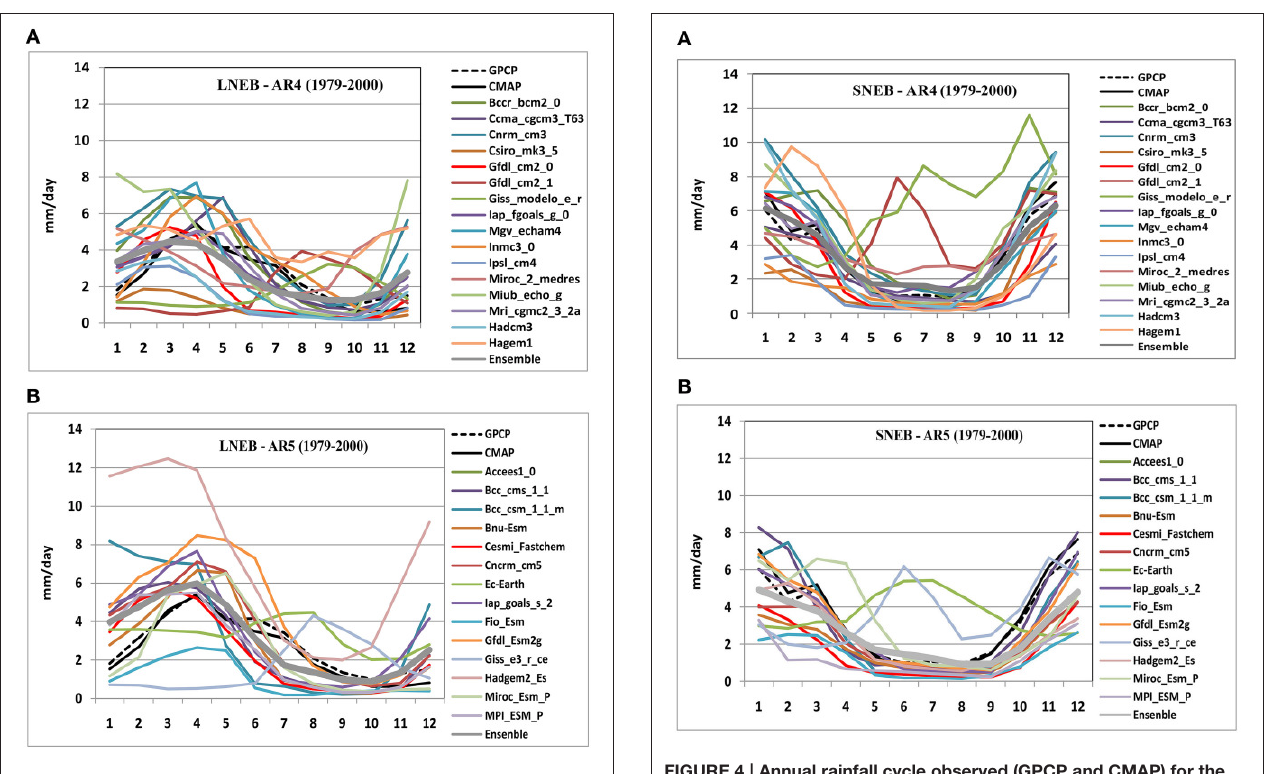
FIGURE 3 | Annual rainfall cycle observed (GPCP and CMAP) for the LNEB over the period 1979–2000 and simulated CMIP3-AR4 (A) CMIP5-AR4 (B) models.